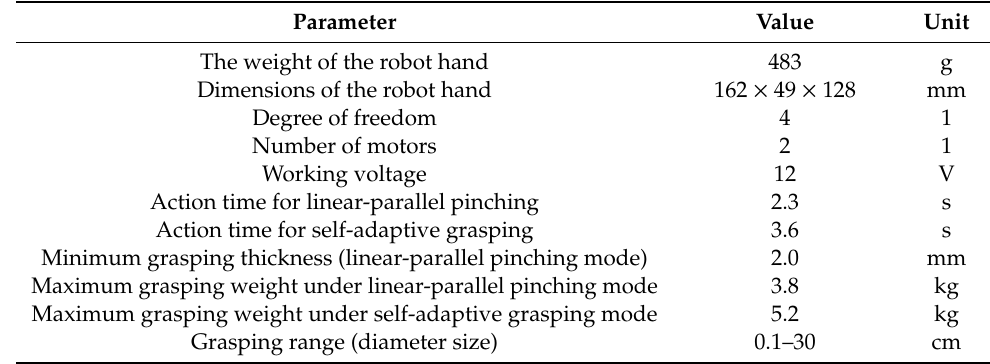
Table 1. Basic parameters and test results.